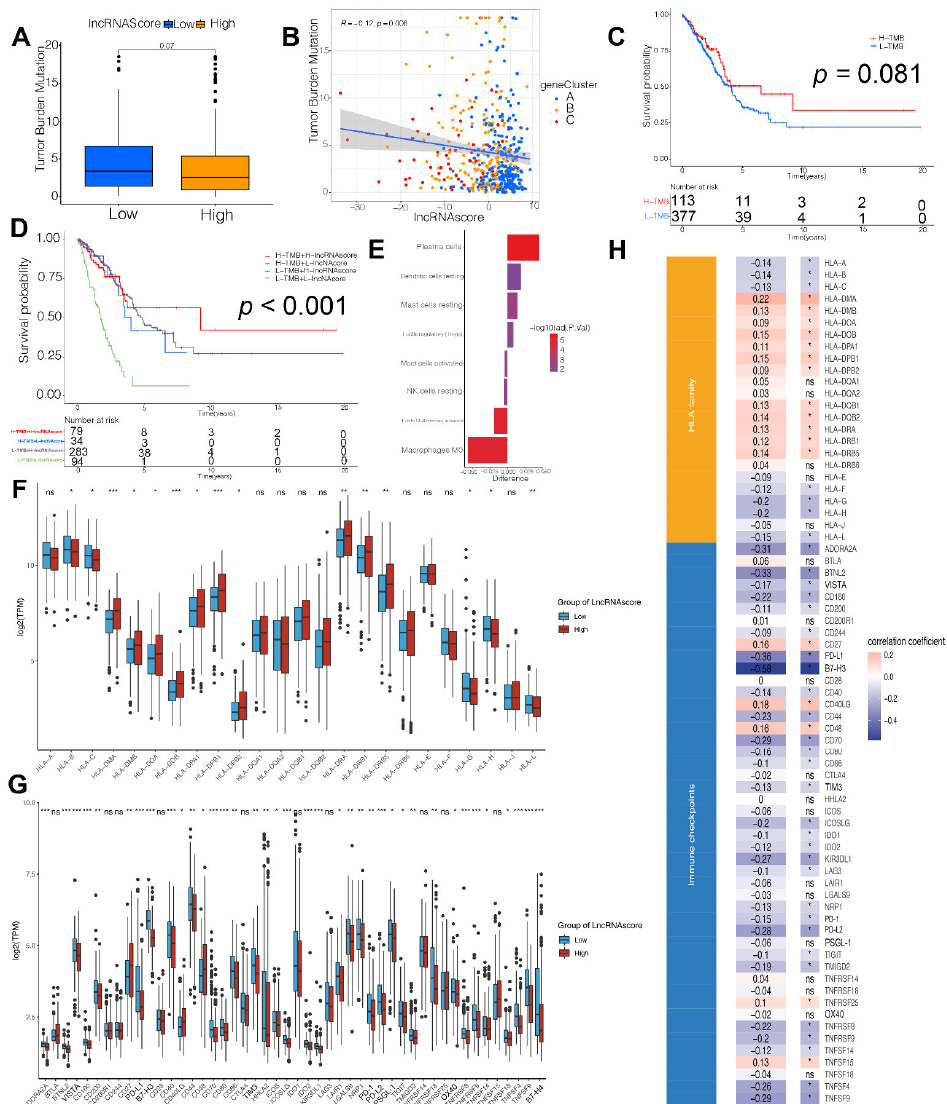
Figure 4. LncRNA score correlated with immune checkpoints. ( A ) Comparison of tumor mutation burden (TMB) in the high and low lncRNA score group; ( B ) Correlation between the lncRNA score and TMB; ( C ) Kaplan–Meier curves of survival in the high and low TMB groups; ( D ) Survival analyses for patients stratified by both lncRNA score and TMB using Kaplan–Meier curves; ( E ) Difference in the relative abundance of immune cell infiltration in TME between the high and low lncRNA score groups. Difference > 0 indicates that the immune cells were enriched in the low lncRNA score group, and the column color represents the statistical significance of the difference.; Analyses for ( F ) the expression of HLA family genes and ( G ) immune checkpoints in the lncRNA score groups; ( H ) Correlation analysis for lncRNA score and the expression of HLA family genes/immune checkpoints. * p < 0.05, ** p < 0.01, *** p < 0.001; ns, not significant; TPM, transcript per